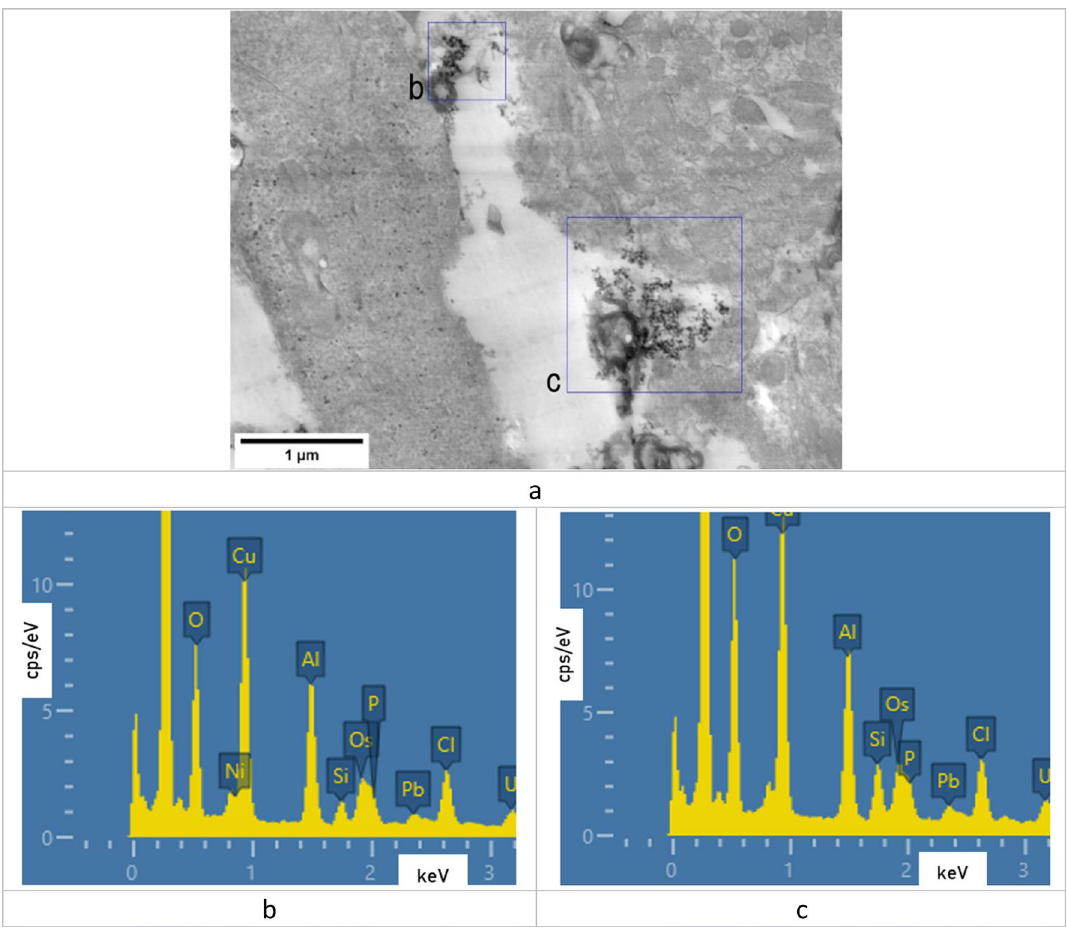
Figure 1. ( a ) STEM image of the olfactory bulb tissues with deposits of lead oxide nanoparticles; ( b ), ( c ) EDS spectra of the regions marked on image ( a